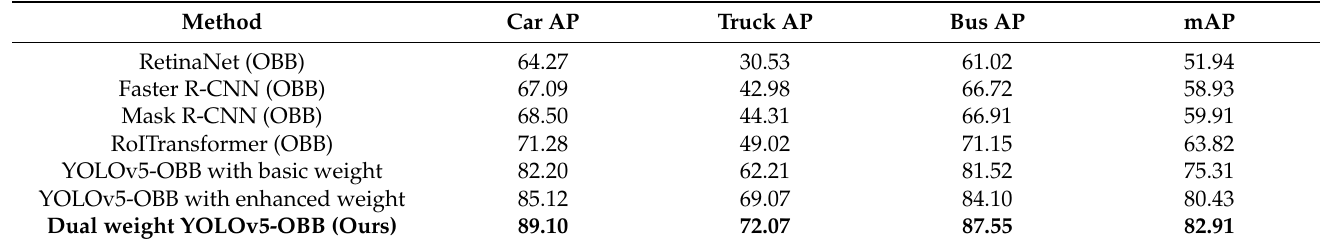
Table 7. Evaluation on mixed dataset (MWVD and DroneVehicle datasets).